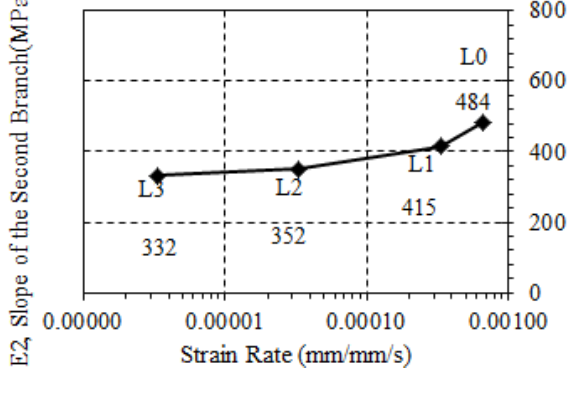
Figure 8. The variation of E 2 with the strain rate for low-strength